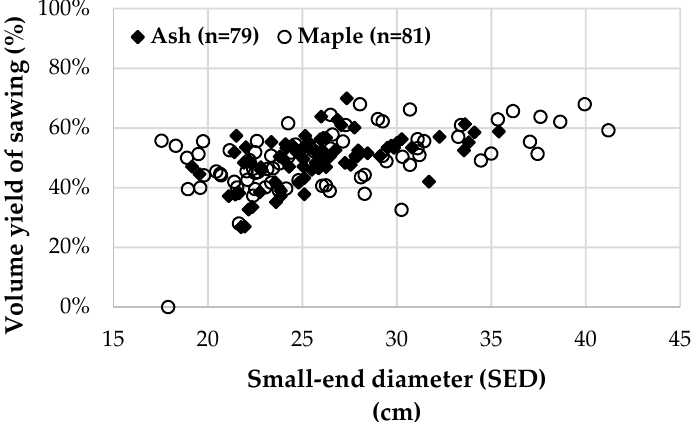
Figure 2. Volume yield of sawing ash and maple depending on the small-end log diameter (inside bark).